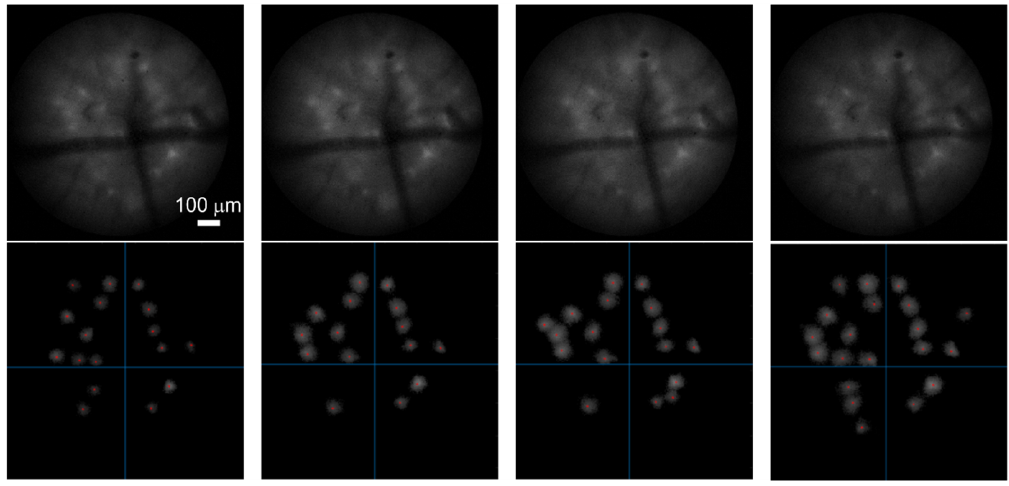
Figure 3. Extracted active centers in a series of images. The first row shows four images of GCaMP3-expressing astrocytes taken at the same field of view at different times. The second row shows the extracted cellular active centers of each image in the first row. The scale shown in the first panel corresponds to all figures.